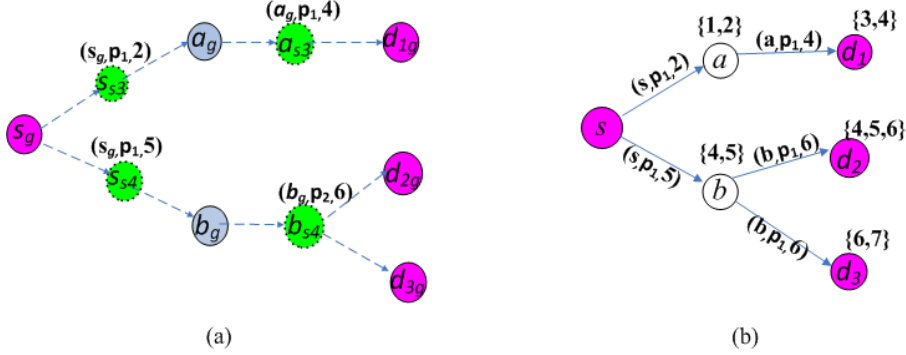
Figure 2. An example of a valid multicast tree.( a ) A valid multicast tree; ( b ) The corresponding multicast tree and transmitting schedules.